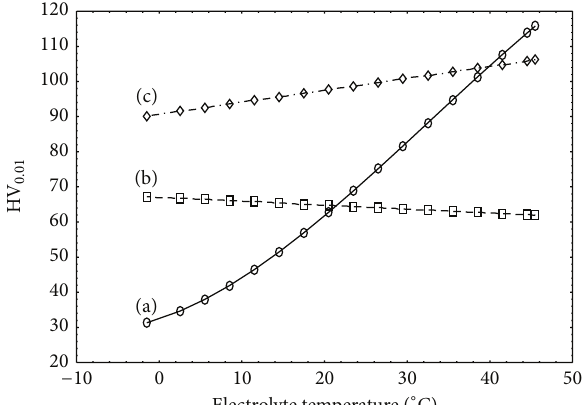
Figure 11: The dependence of the layer microhardness on the tem- perature of the electrolyte: c (H 2 SO 4 ) = 1.99mol ⋅ L −1 , c (C 2 H 2 O 4 ) = 0.06 mol ⋅ L −1 , U = 10.5 V, t = 20 min. (a) 1A ⋅ dm −2 , (b) 3A ⋅ dm −2 , and (c) 5 A ⋅ dm −2 .